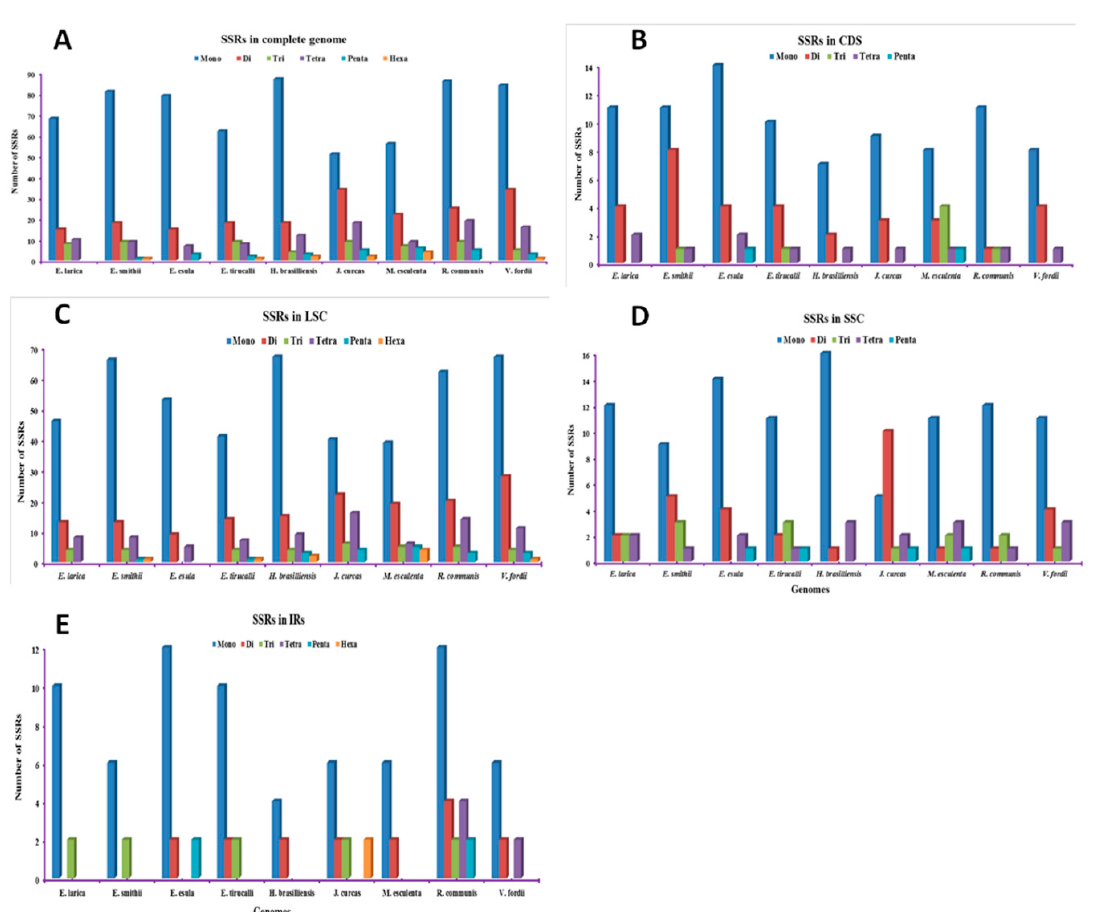
Figure 3. Analysis of simple sequence repeats (SSRs) in chloroplast genomes of E. smithii and E. larica . ( A ) Total number of SSRs present in complete genomes. ( B ) Total number of SSRs present in the CDS of the genome. ( C ) Total number of SSRs present in the LSC of genome. ( D ) Total number of SSRs present in SSC of the genome. ( E ) Total number of SSRs present in IRs of the genome.